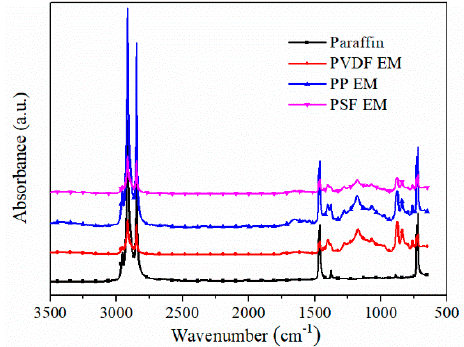
Figure 6 . FT-IR spectrum of paraffin and three encapsulation membranes.